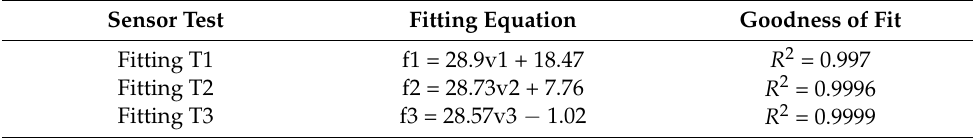
Figure 20. The relationship between the impact force of three impact points and the corresponding voltage signal. Table 3. The functional relationship of the impact model of the sensor test.